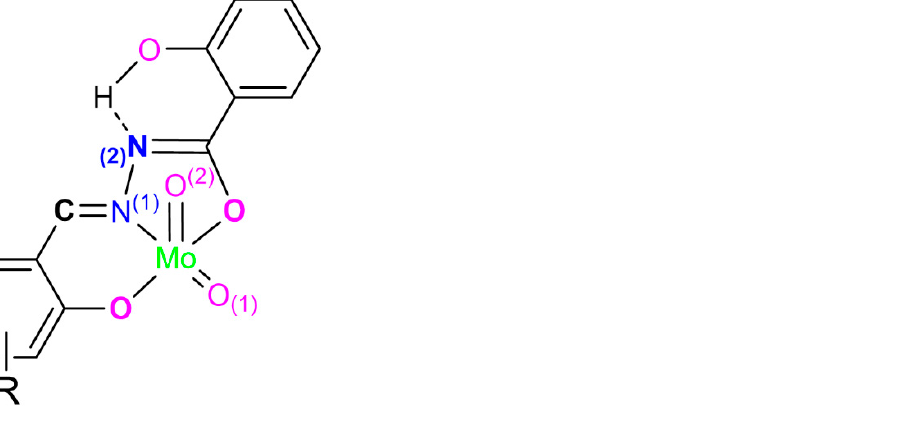
Scheme 4. Representation of the MoO 2 L complex with the numbering of the atoms taken into consideration. For the dihedral angle, follow OCNO (bold letters) in clockwise order.